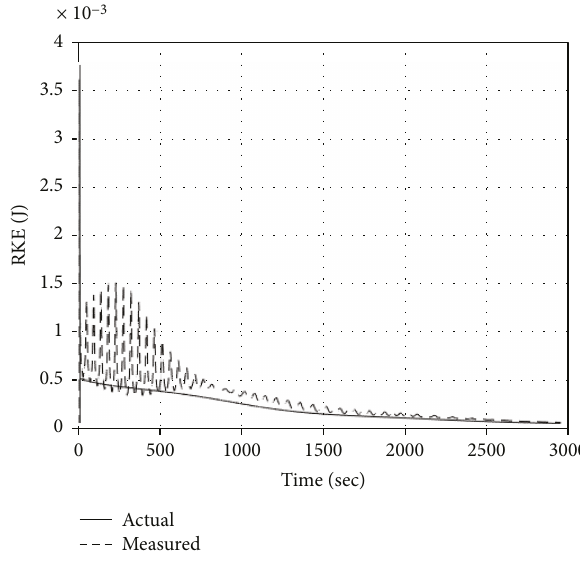
Figure 4: T r high frequency measurement